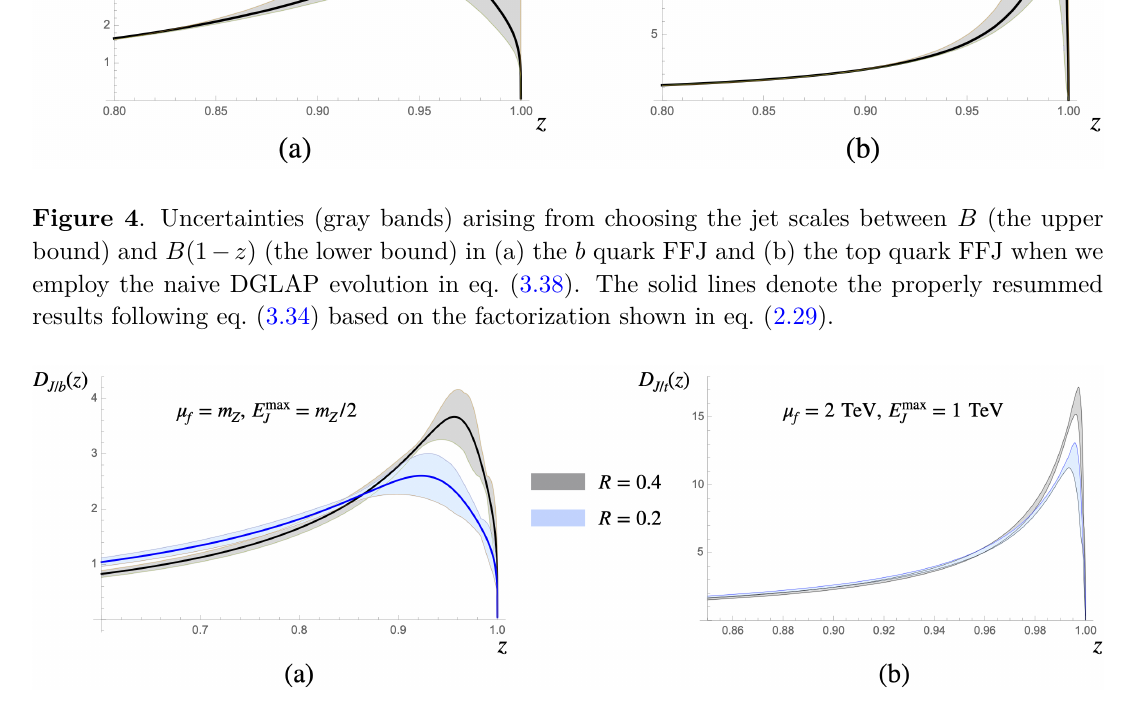
Figure 5 . The collinear and the csoft scale variations of the resummed results for (a) the b quark and (b) the top FFJs as described in the paper. The solid lines in denote the results with the default scales given by µ c = B and µ cs = B (1 − z )